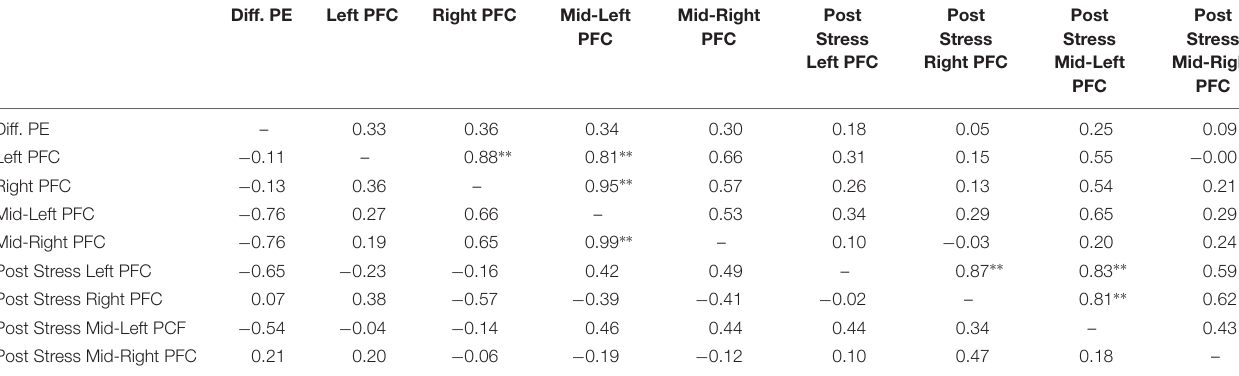
TABLE 5 | Bivariate correlations between oxyHB and change in perseverative errors for female participants as a function of condition (Stress vs. Control), values above the diagonal are for the control group and values below the diagonal are for the stress group. Diff.